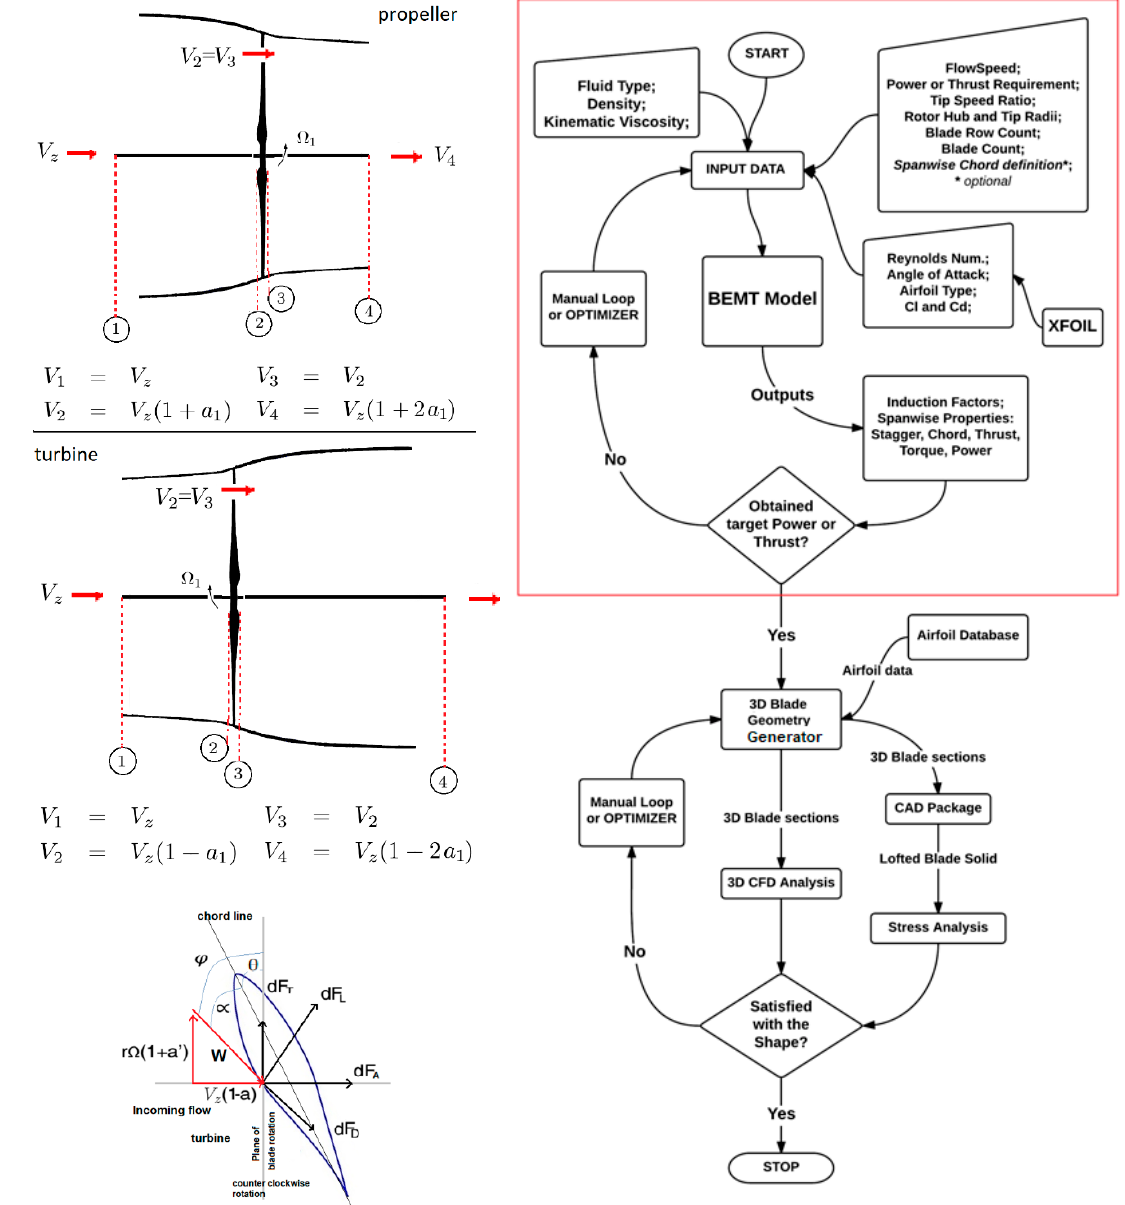
Figure 8. Low-fidelity BEMT tool for unducted rotors connected with high-fidelity loop.